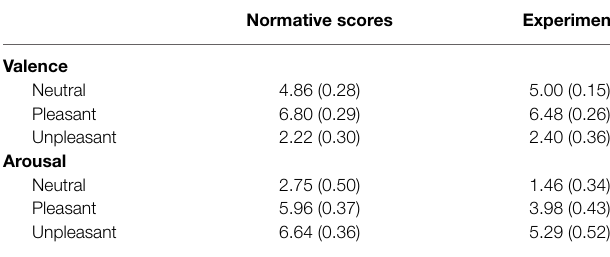
TABLE 1 | Mean ( + SD) for SAM scores of valence and arousal of both the normative scores from the IAPS manual and the scores from the current